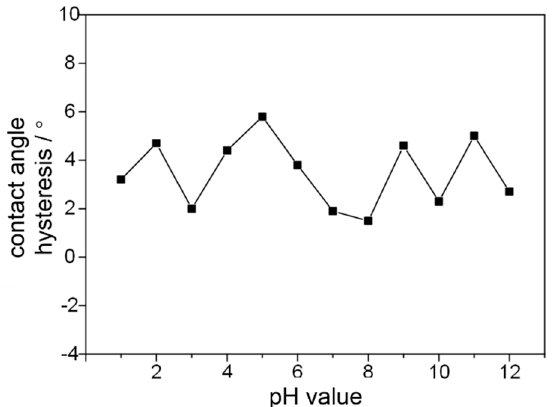
Figure 4. Water contact angle hysteresis of the super-hydrophobic methyl silicone resin/SiO 2 composite coating after infiltrating with acidic and base liquids for 24 h.